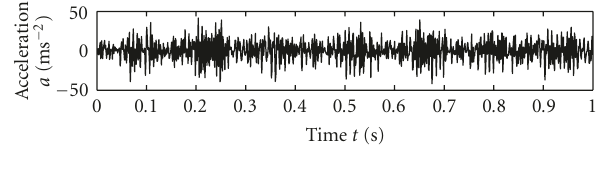
Figure 1: Acceleration vibration signal of a gear with a broken tooth.